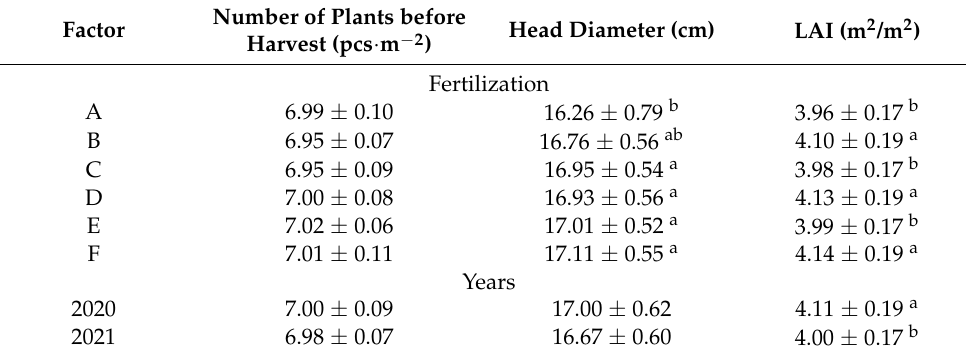
Table 4. Measurement of selected sunflower parameters.